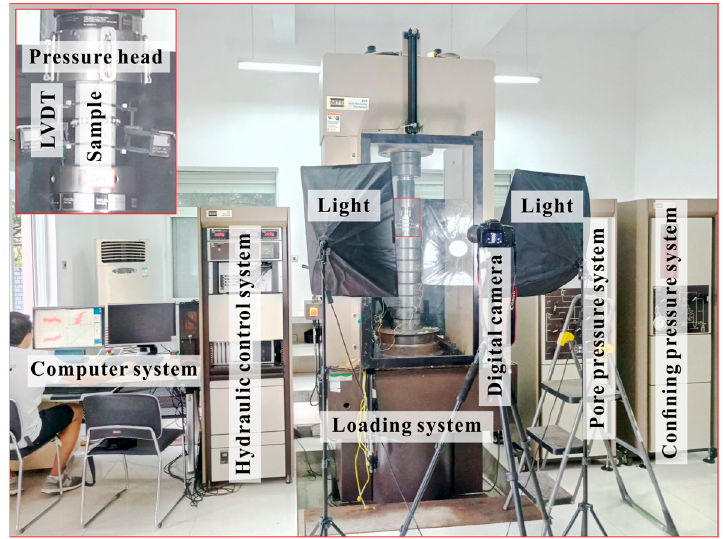
Figure 5. Apparatus for uniaxial compressive test.